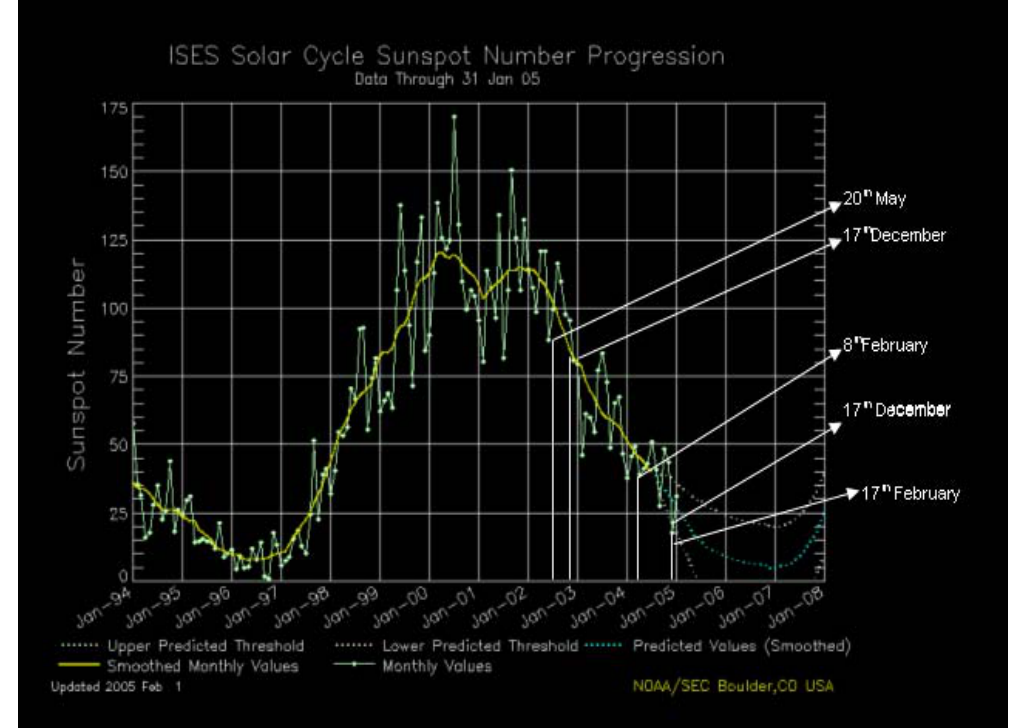
Figure 1. Influence of V838 Monoceras star flares (cosmic rays) on sunspot numbers. 20th May 2002, 17 th December 2002, 8 th February 2004, 17th December 2004 and 17 th February 2005 show low sunspot numbers and higher cosmic ray (identified by cosmic ray detector). Courtesy